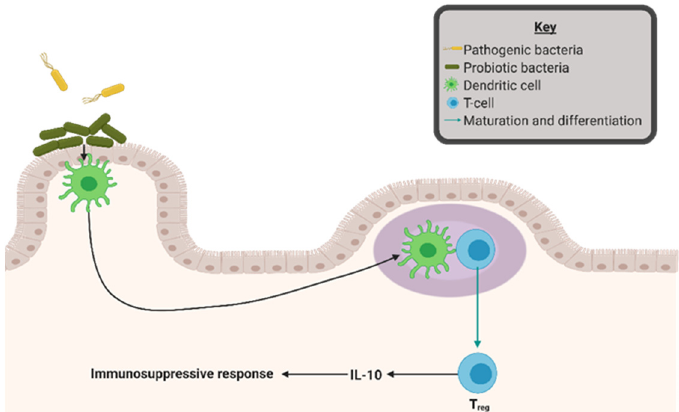
Figure 3. Probiotic interactions in the gut can modify inflammation. Probiotic bacterial species adheres to the gut lining, strengthening the gut epithelial barrier, and allows for competitive inhibition of pathogenic microorganisms. Additionally, probiotic bacteria produce anti-microbial substances promoting anti-inflammatory response in the gut-associated lymphoid tissue. Figure was created with BioRender.com.